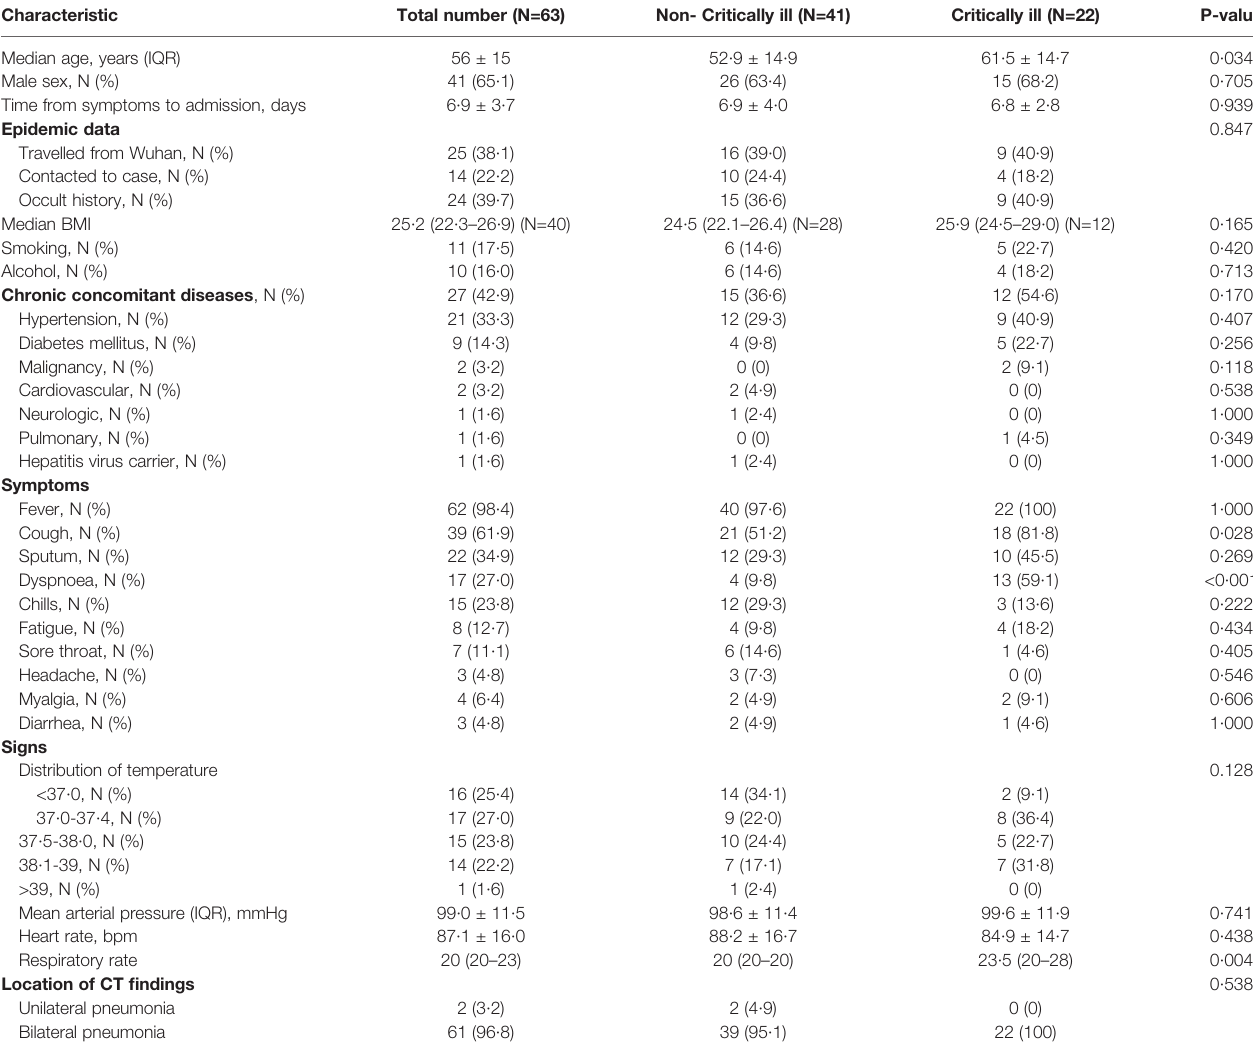
Data are shown either as the number of observations, percentage, or median and interquartile